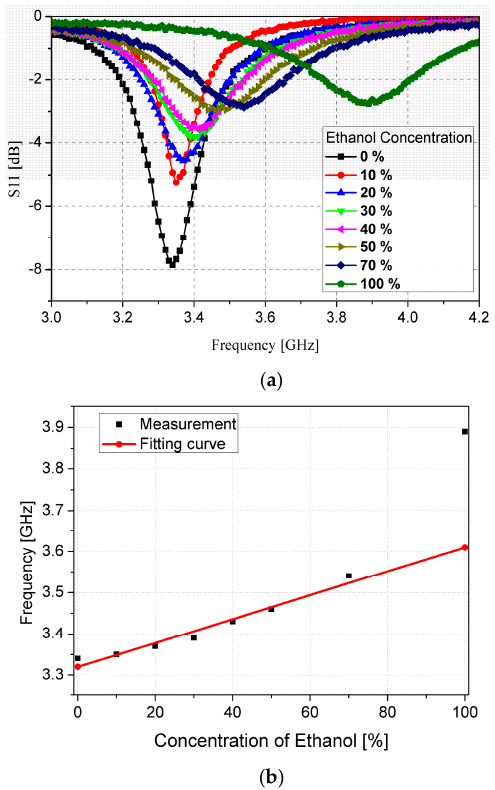
Figure 10. ( a ) Measured S-parameters; ( b ) Resonant frequency of ethanol with different concentrations, from 0% (DI water) to 100% with the fitting curve of y = 2.9 × 10 − 3 x + 3.32 in GHz.